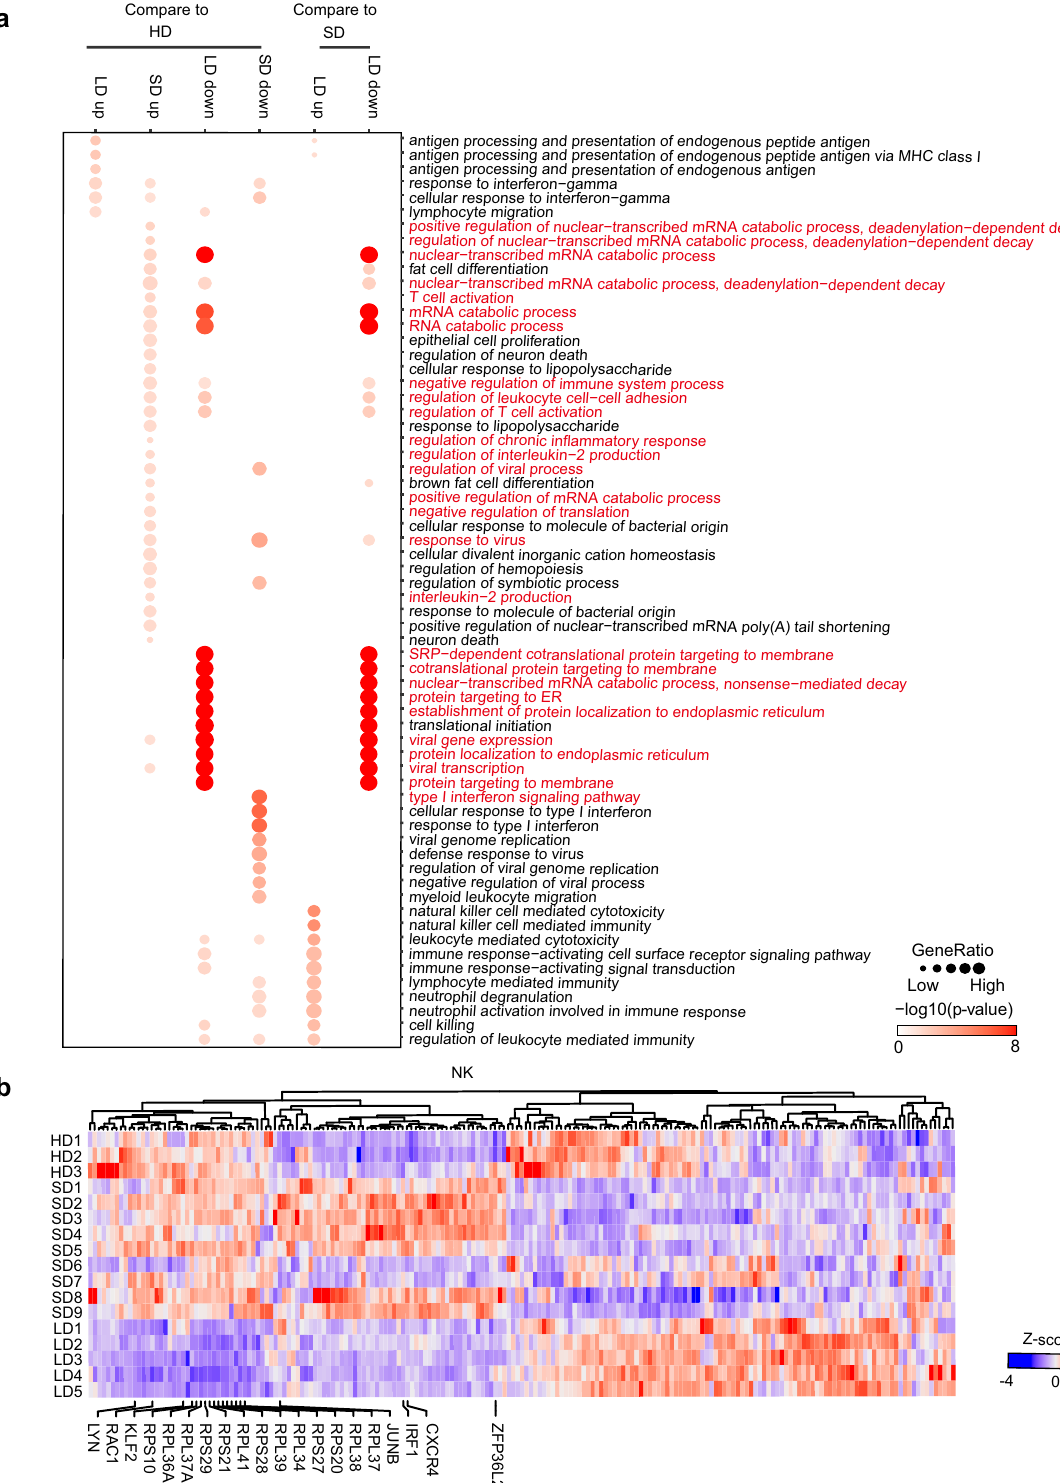
Fig. 6 Immunological features of NK cells in LDs and SDs. a Enriched GO pathways of COVID-19 groups in NK cells (top 2 columns: DEGs between LDs and SDs, bottom 4 columns: DEGs for SDs and LDs compared to HDs. Pathways enriched by SDs upregulated genes are labeled in red. The color intensity indicates the enrichment p values and the point size indicates the ratio of gene enrich in each pathway. b Hierarchical clustering of expression of DEGs in NK cells at sample level. The color intensity indicates the relative expression of each